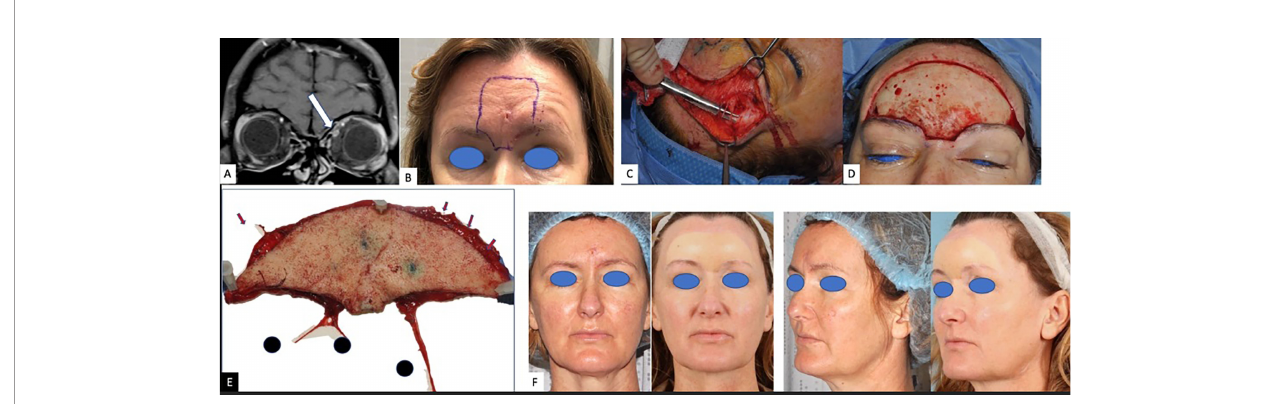
FIGURE 2 | Case 2: a 50-year-old woman with basosquamous carcinoma. (A) Coronal fat-suppressed contrast-enhanced T1-weighted image shows asymmetric enhancement along the superior orbit (arrow), adjacent to the superior rectus muscle. (B) Pre-operative forehead recurrence. (C) Intra-operative dissection of the distal sensitive branches of the forehead sensory nerves. (D) Defect of the forehead after resection of the recurrence with 2 cm margins. (E) Pathological sample. Red arrows showing the tagged distal sensory branches. 1 = right supraorbital nerve; 2 = right supratrochlear nerve; 3 = left supraorbital nerve dissected until its entrance in the superior orbital fi ssure. The left supratrochlear nerve is missing and was dissected separately as interrupted by a pre-operative biopsy. (F) Pre - and 14-month post-operative clinical photos. Post-operative proton radiotherapy spared the reconstructed forehead and focused on the retro-orbital and skull course of the supratrochlear nerve including the Gasser